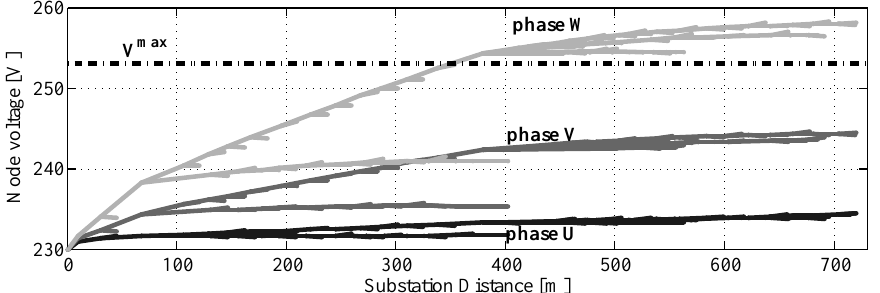
Figure 5. Grid voltages when no pricing scheme are used to control the